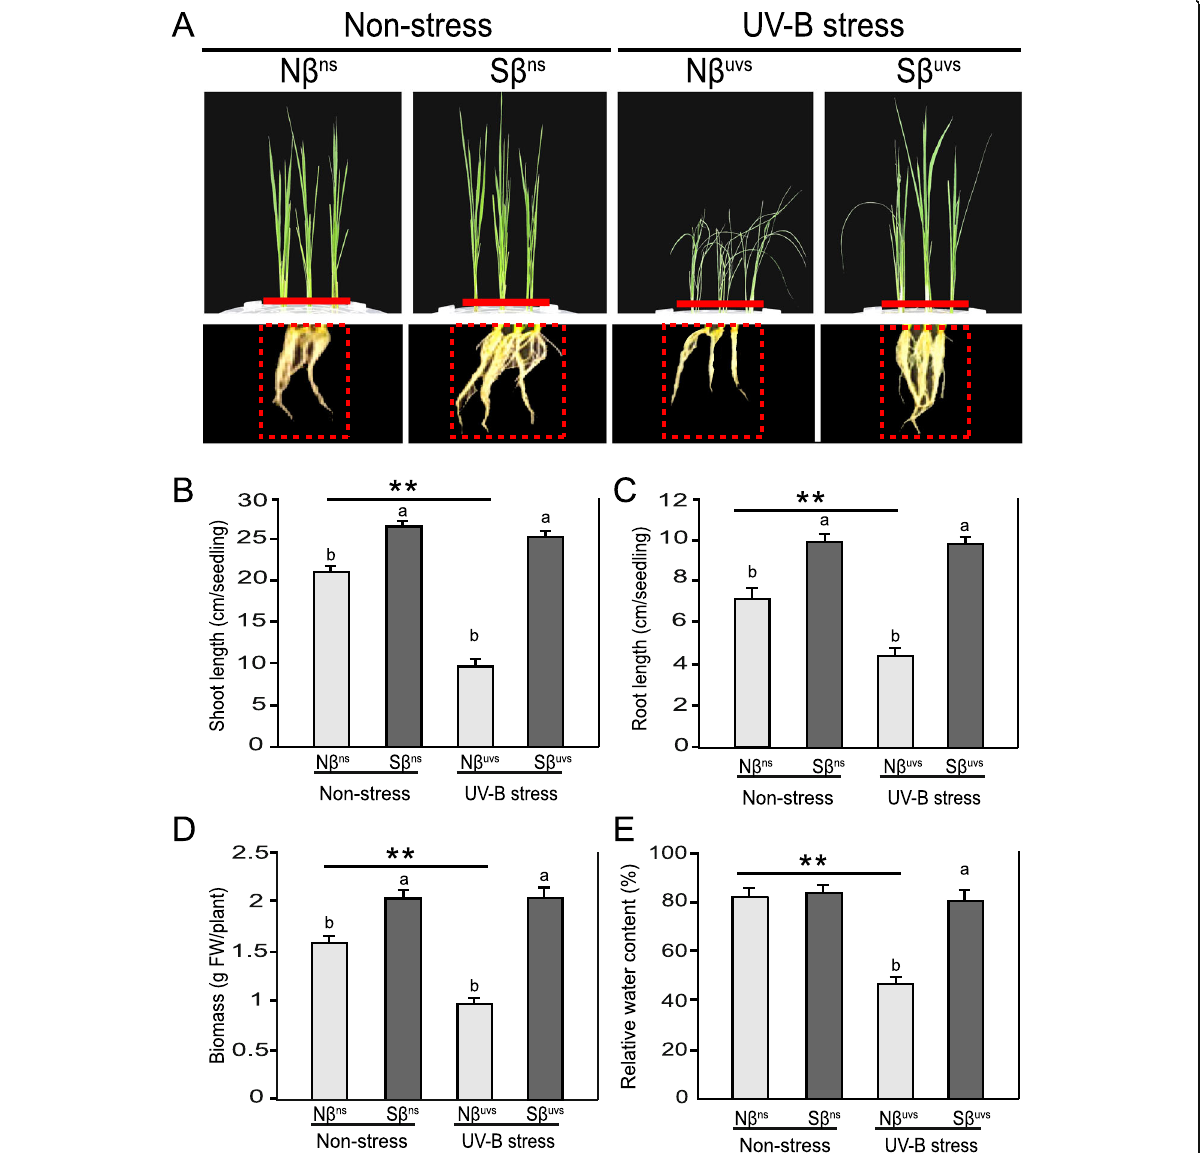
Fig. 1 Effects of prolonged UV-B stress on N β and S β seedlings. A Photographs of the shoots (upper panel) and roots (lower panel) of N β and S β plants under non-stress and after 5-day-long (6 h/day) UV-B stress. B Shoot length, C root length, D plant biomass represented in g FW/plant, and E relative water contents from the leaves of N β and S β seedlings under non-stress and stress conditions were subsequently measured for growth performance. The means with different letters are significantly different (P < 0.05) within the same treatment (N β ns vs. S β ns and N β uvs vs. S β uvs ). Lines with asterisks indicate significant differences between non-stress and UV-B stress conditions of the same plants (N β ns vs. N β uvs and S β ns vs. S β uvs ), as determined by Student ’ s t test (* P < 0.05, ** P <